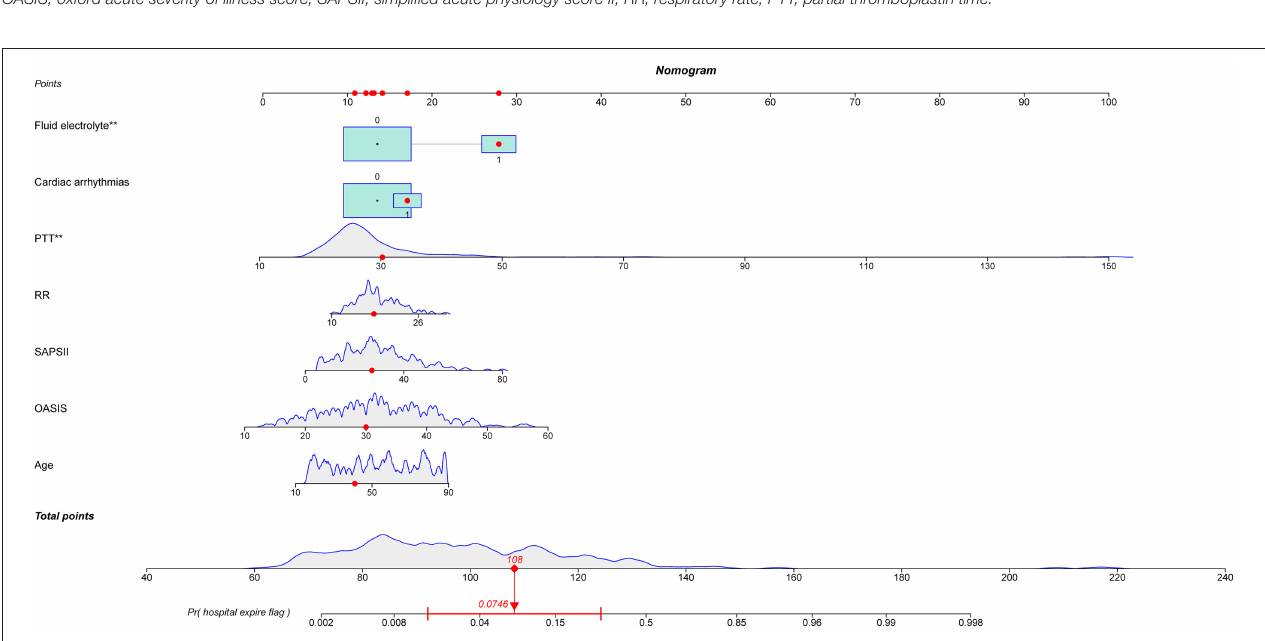
FIGURE 3 | Nomogram to predict the risk of in-hospital mortality in patients with thoracic spine fractures without neurological injury in the ICU. PTT, partial thromboplastin time; RR, respiratory rate; SAPS II, simplified acute physiology score II; OASIS, oxford acute severity of illness score. ** means p <